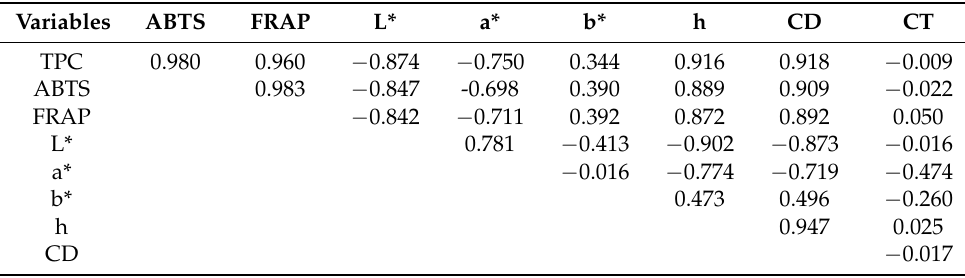
Table 3. Spearman correlation among the spectrophotometric assays Folin–Ciocalteu (TPC), ABTS and FRAP and colour parameters (L*, a*, b*, h, CD,